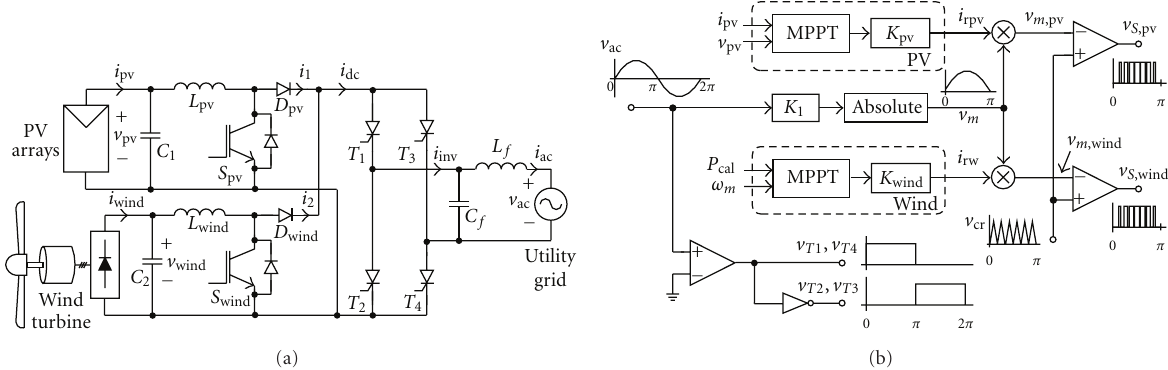
Figure 3: Proposed grid-connected CSI for hybrid PV/wind power generation—(a) power converter scheme and (b) system control scheme.